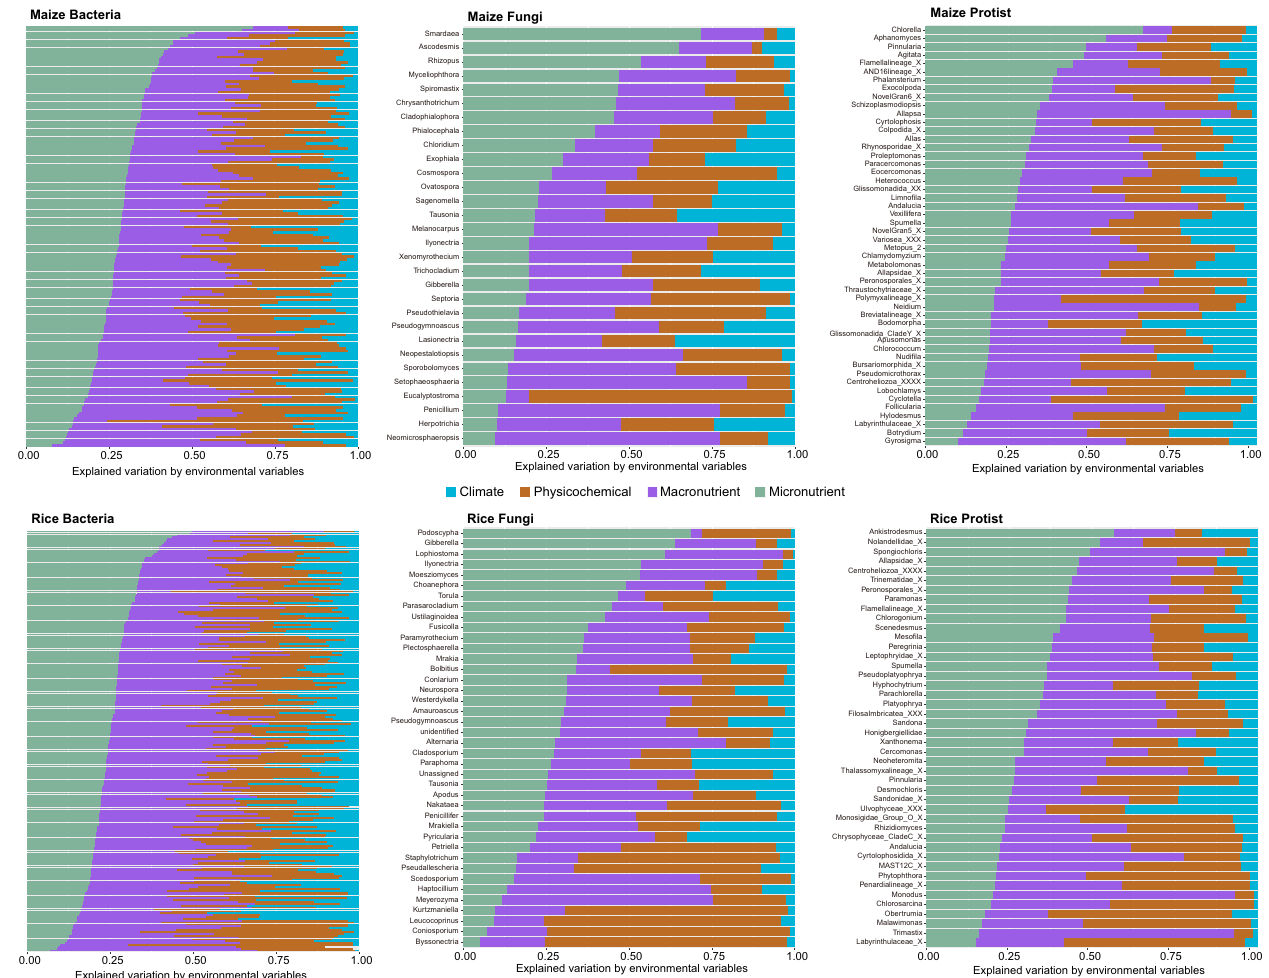
Fig. 4 Environmental variables explaining the structure of bacterial, fungal and protistan communities. Contribution of climate, soil physicochemical properties, macronutrients and micronutrients to the variation explained by the complete random forest model for each microbial genus where out-of-bag R 2 >